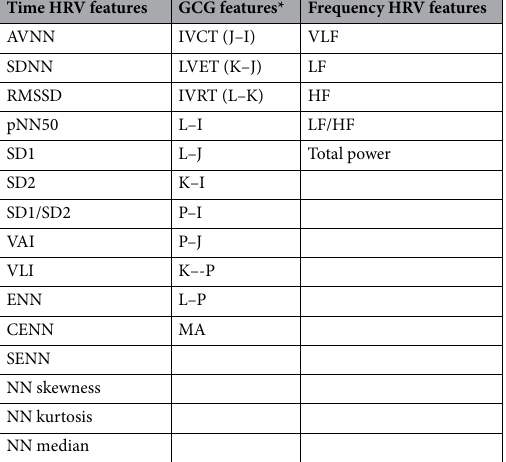
Table 2. Feature space by group types. *Mean, median, standard deviation, skewness, kurtosis, entropy, min, and max were calculated for every parameter in this column.